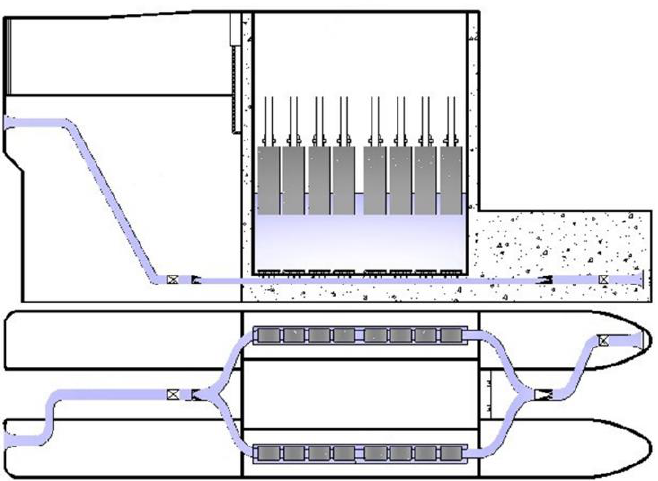
Figure 4. Schematic diagram of the longitudinal culvert filling–emptying system.